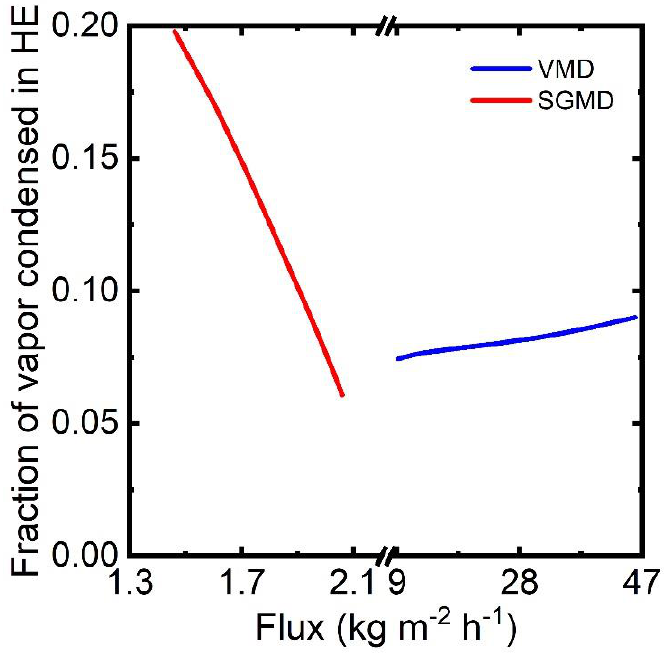
Figure 13. Partial condensation of vapor in VMD and SGMD-based desalination process.